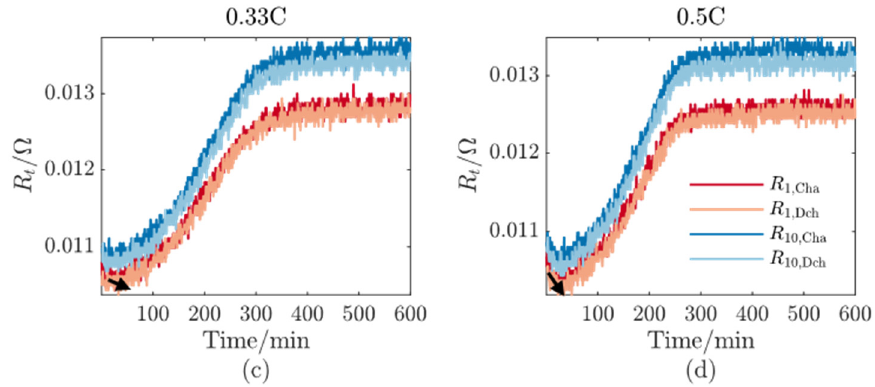
Figure 5. The internal resistance results of ( a ) experiment #2-1; ( b ) experiment #2-2; ( c ) experiment #2-3; ( d ) experiment #2-4.